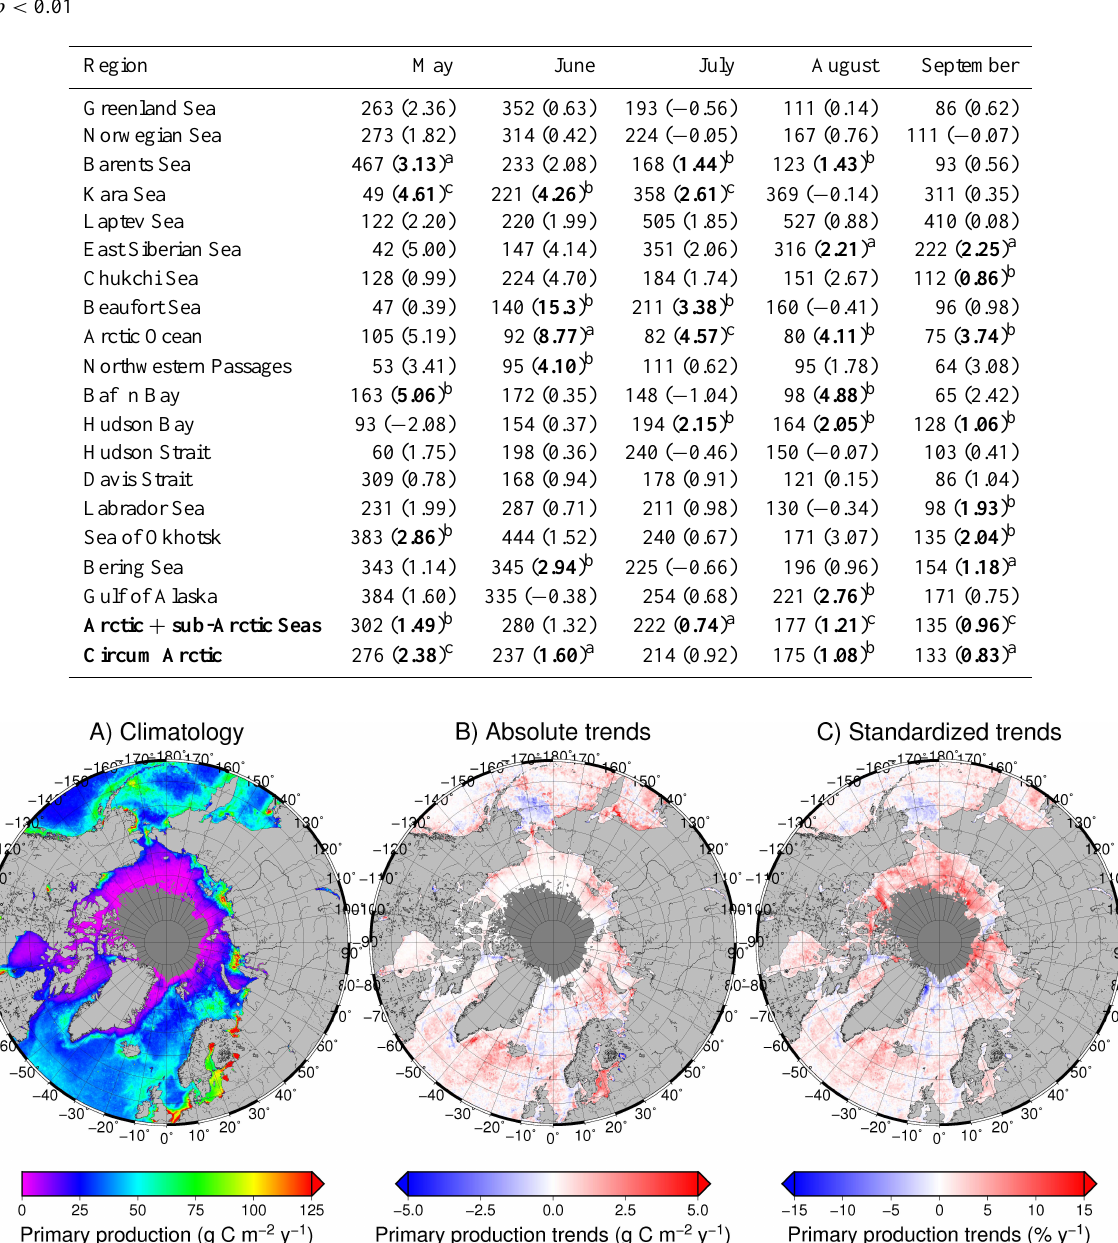
Table 3. Regionally averaged daily flux of PP (in mg C m − 2 d − 1 ) and its relative trends computed for the 1998 to 2010 period (in parenthesis, in %yr − 1 ). Significant trends are in bold text with superscript indicating the level of significance: (a) 0 . 05 < p < 0 . 1, (b) 0 . 01 < p < 0 . 05, and (c) p < 0 . 01